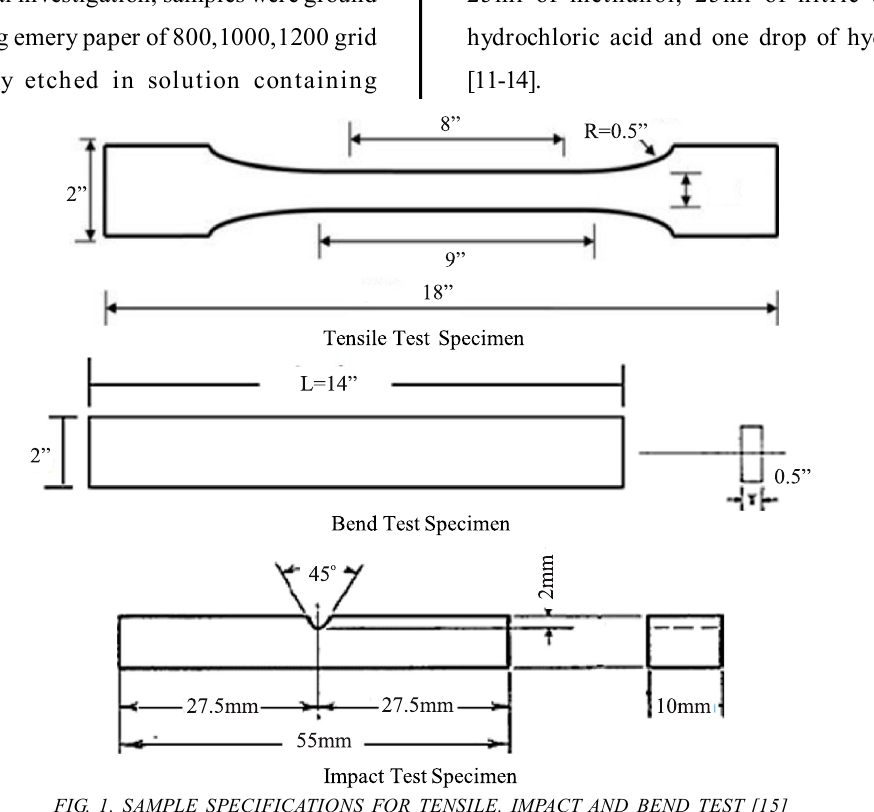
FIG. 1. SAMPLE SPECIFICATIONS FOR TENSILE, IMPACT AND BEND TEST [15]